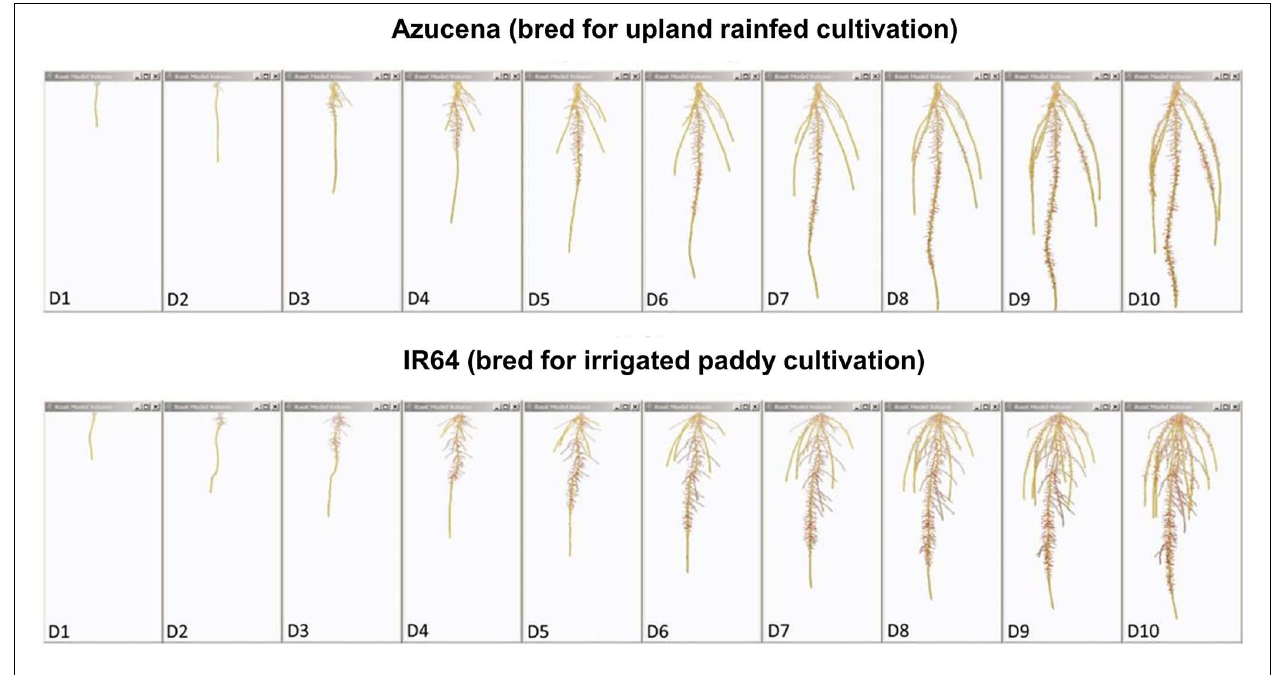
FIGURE 4 | Root system models of two rice varieties bred for contrasting agricultural systems. These root system models, generated from image series of seedling rice root systems of cv. Azucena (top), and cv. IR64 (bottom) over 10 days of growth (D1–D10) in a clear, gellan-gum nutrient media show how the breeding of crop varieties adapted to particular cultivation systems and agroecological environments has resulted in inadvertent selection for different crop root architectures. Azucena, a rice variety bred for an upland rainfed growing environment develops a deeply rooted primary and